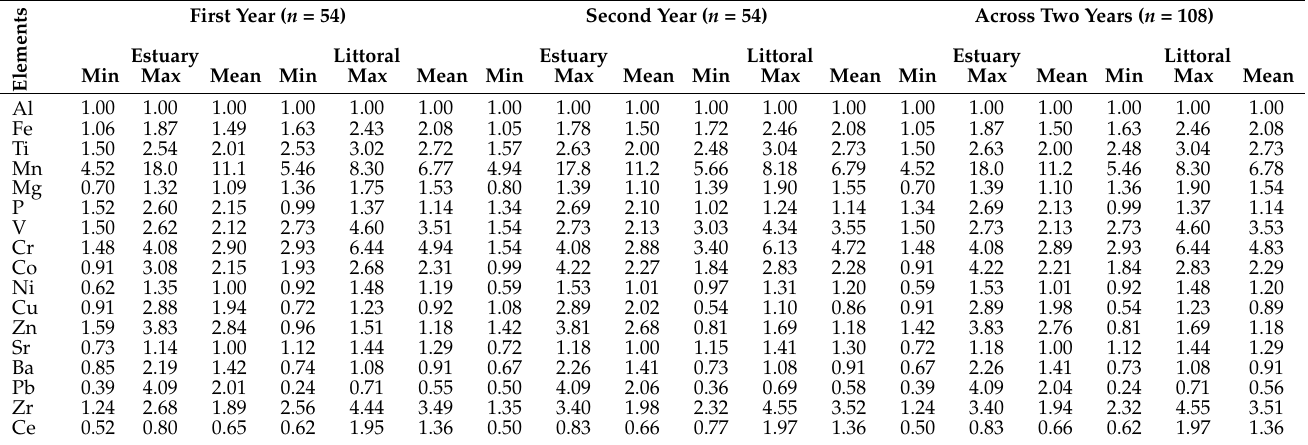
Table 5. The statistical description of enrichment factor (EF) in studied sediment